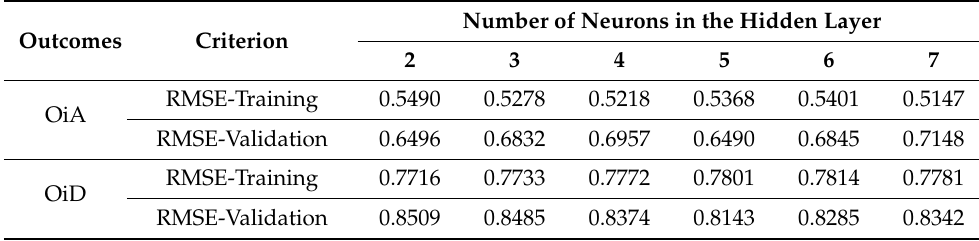
Table 8. RMSE variation of the ANN models with the number of neurons in the hidden layer. Number of Neurons in the Hidden Outcomes Criterion